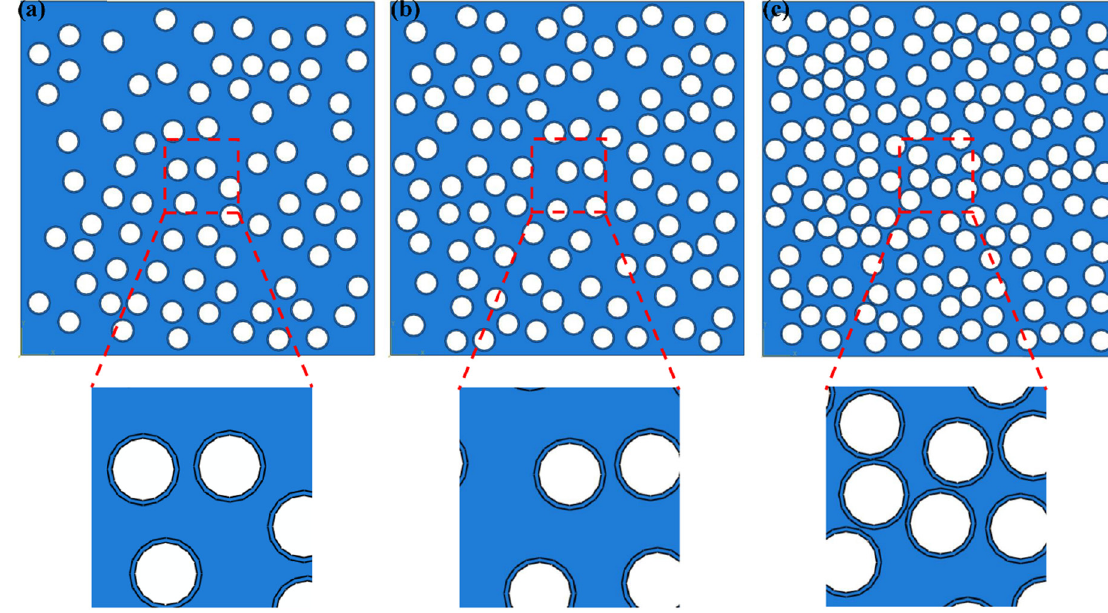
Figure 3: Water di ff usion model for three - phase composites with di ff erent fi ber volume fractions : ( a ) 20%, ( b ) 26%, and ( c ) 40%.